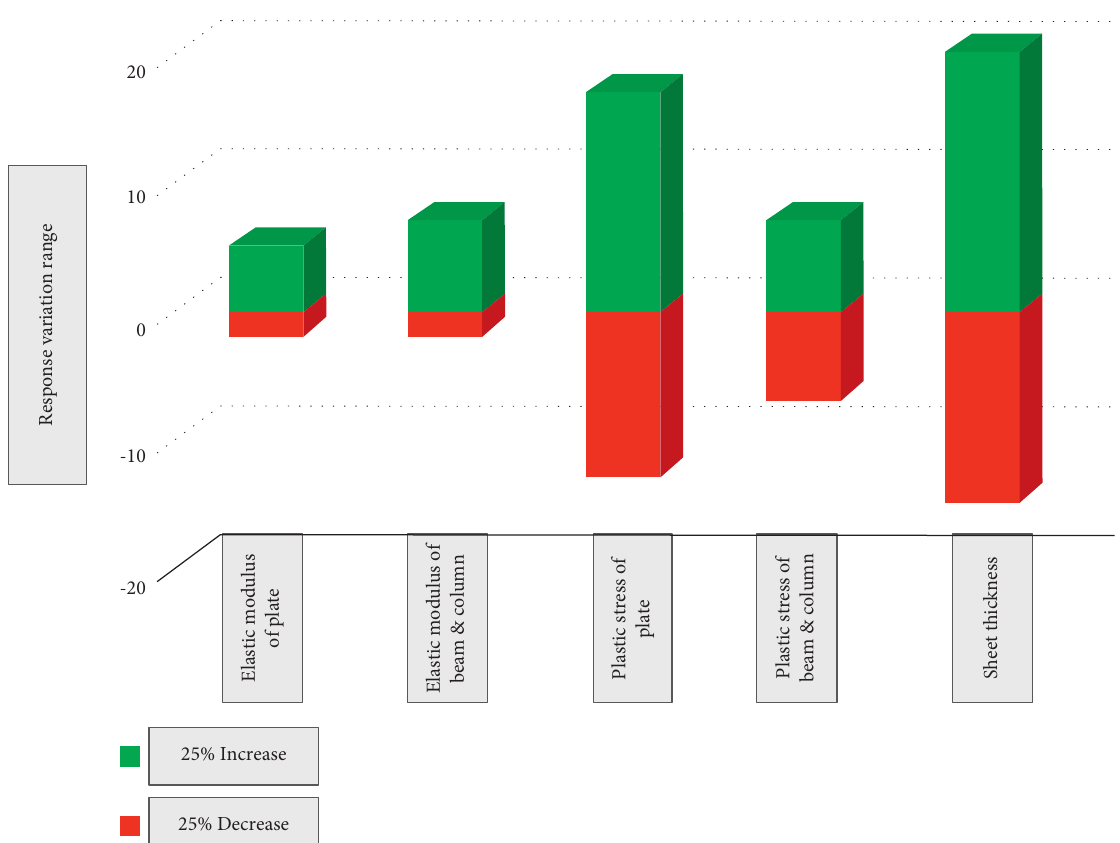
Figure 14: Comparing the effect of changes in effect quantities on shear wall